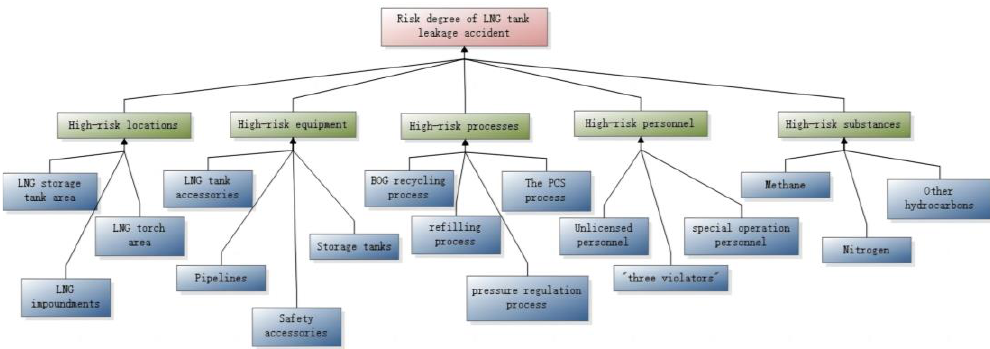
Figure 7. Structure of AHP models.